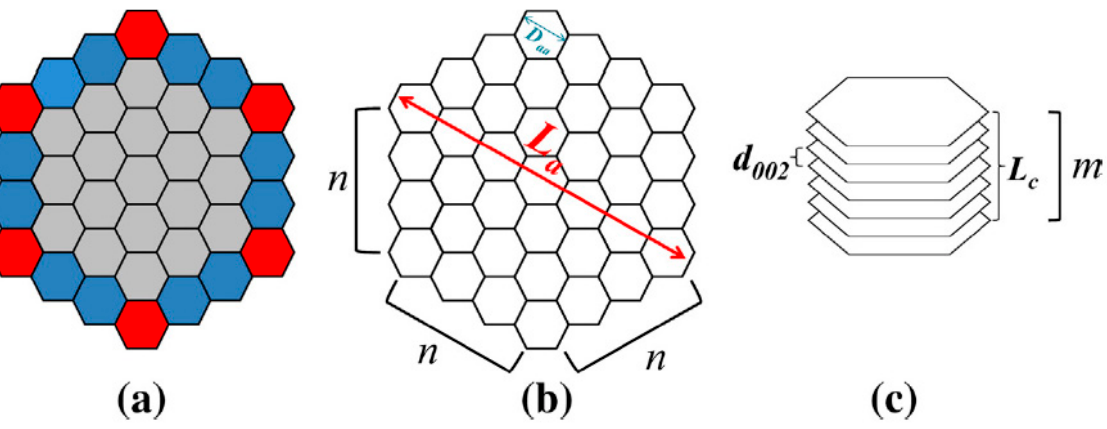
Figure 4. Idealized crystallite representation used in the coke model developped by Ouzileau et al. ( a ) idealized ‘‘hexagonal’’ plane with n = 4 showing the positions of the 𝐶4 3 sites (Red hexagons), the 𝐶5 4 sites (Blue hexagons) and the 𝐶6 6 sites (Gray hexagons); ( b ) crystallite size L a , D aa and n parameters; ( c ) crystallite height L c and d 002 from the stacking of m planes; permitted from ref. [64]. It is assumed in our model that the source of methane emissions during the carboni ‐ zation process is the cracking of side chains in the structure of some aromatic compounds.